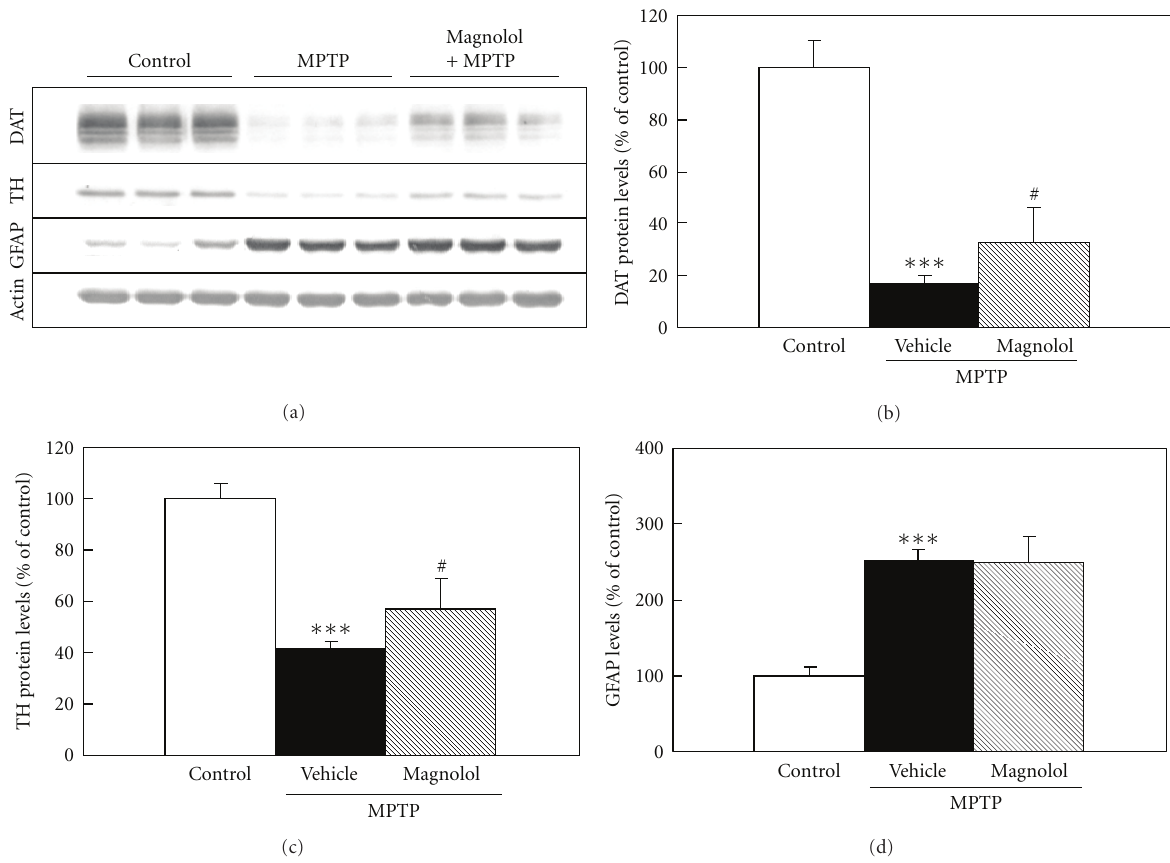
Figure 2: E ff ect of pre-MPTP treatment with magnolol on DAT, TH and GFAP protein levels in the striatum of C57BL/6 mice. Mice were administered daily with magnolol (30 mg/kg) for 5 days, and received 4 injections of 20mg/kg MPTP at 2h intervals at the day after the last magnolol treatment. The evaluations were performed at 3 days after MPTP treatment. Representative immunoblots of DAT, TH and GFAP protein in the striatum are shown (a). Actin protein was used as housekeeping protein. Immunoblots of DAT (b), TH (c), and GFAP (d) in the striatum were quantified in each group. Densitometric analysis of protein bands were performed using software (Image J 1.36, NIH). The data were expressed as % of control. Results are means ± SD ( n = 6-7) from two independent experiments. Statistical comparisons were carried out by one-way ANOVA followed by Sche ff e test. ∗∗∗ P < 0 . 001 versus control, # P < 0 . 05 versus MPTP +